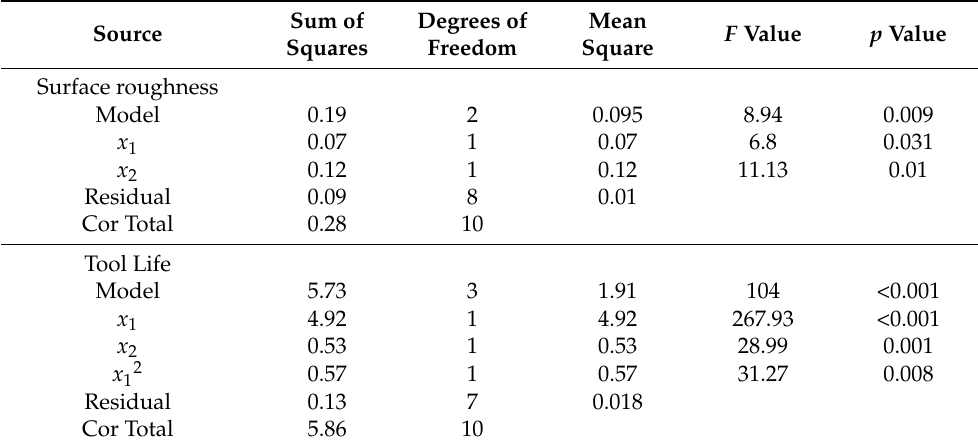
Table 3. Result of ANOVA table for tool life and surface